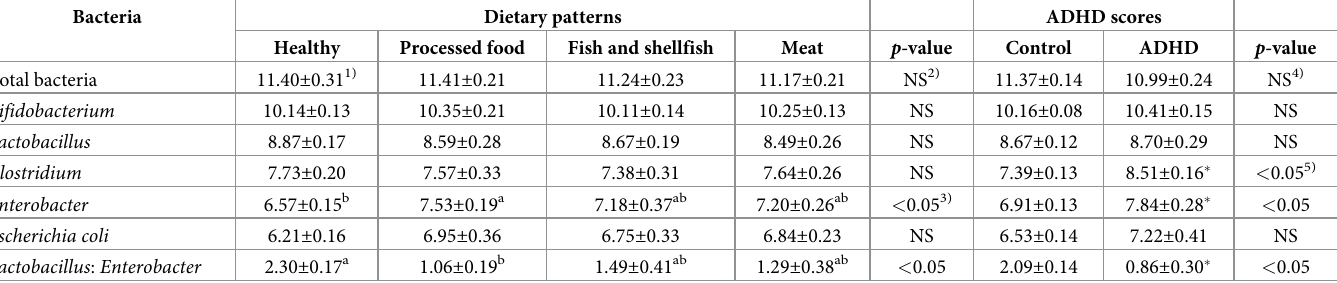
Table 4. The counts (log10 16S rDNA gene copies g-1 of colonic digest) of different bacterial groups measured by quantitative real-time polymerase chain reaction (qPCR).